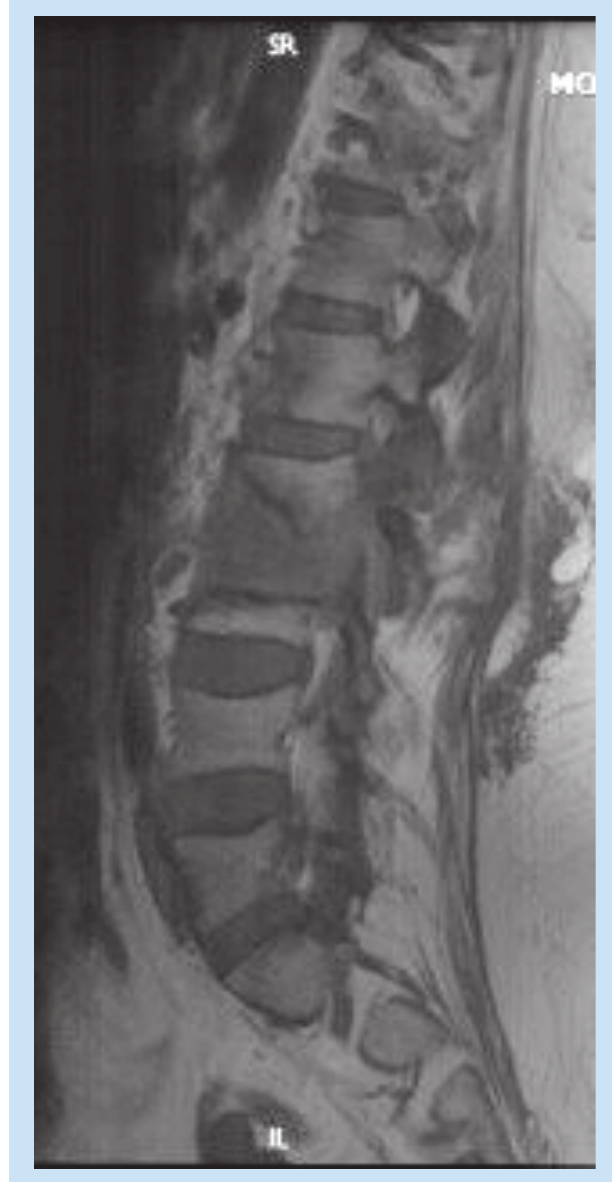
Fig 1. T1 sagittal image. Partial destruction of the anterior and posterior vertebral bodies of L2 and